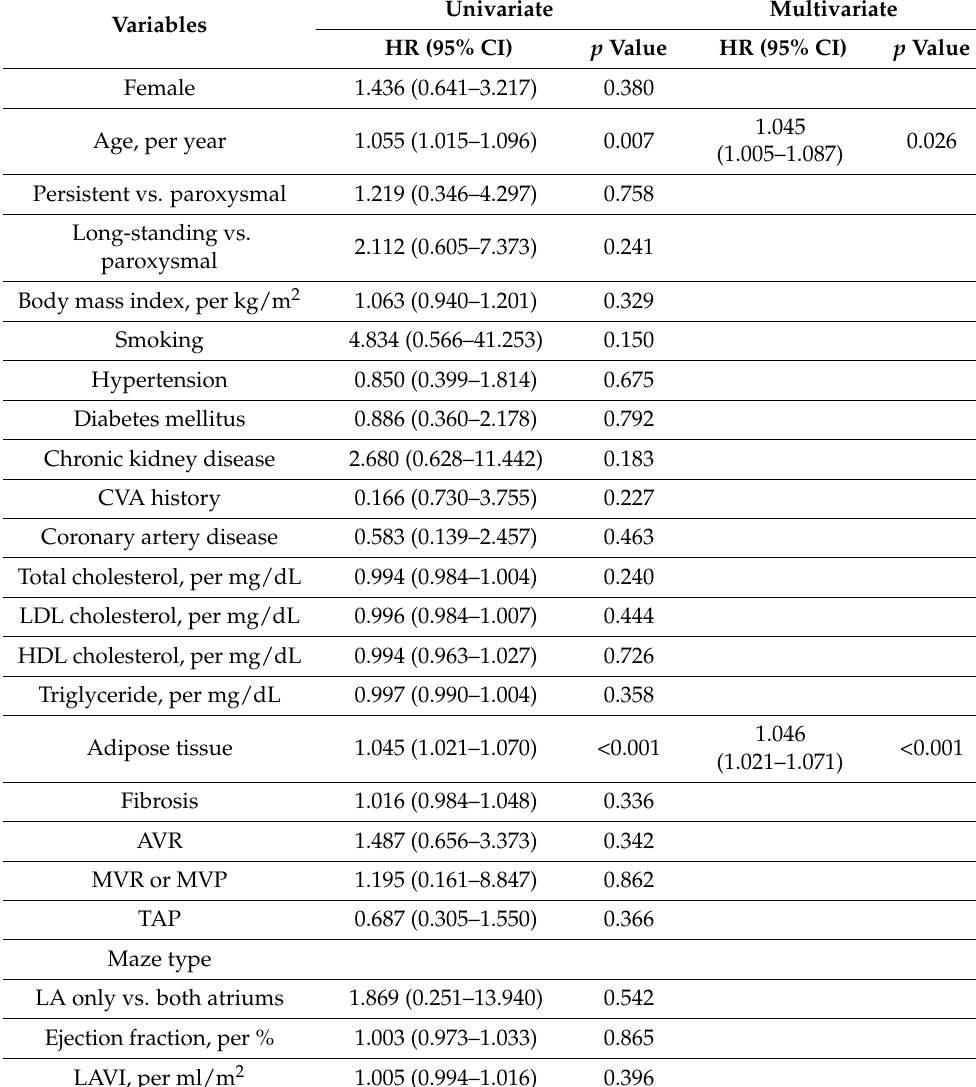
Table 4. Cox regression analysis for atrial fibrillation